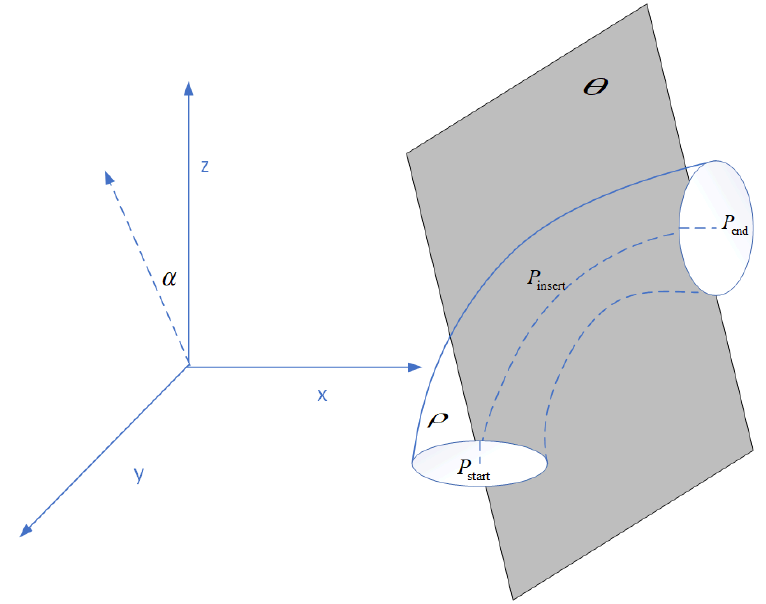
Figure 3. Description of the space curve in Cartesian coordinates. Parameters , , and determine the position of the curve, and deter- mines the shape of the curve. If appropriate, , , , and are given, and the path of the robot in the feasible space can be obtained.